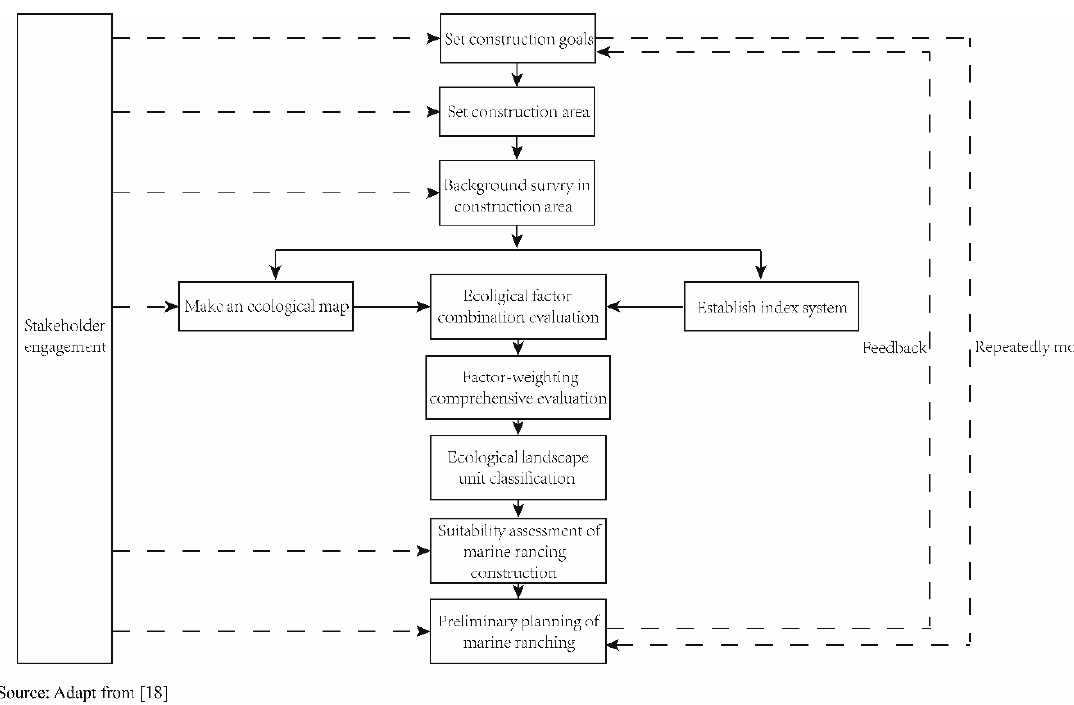
Figure 2. Procedures and linkages in marine spatial planning (MSP) implementation [18].